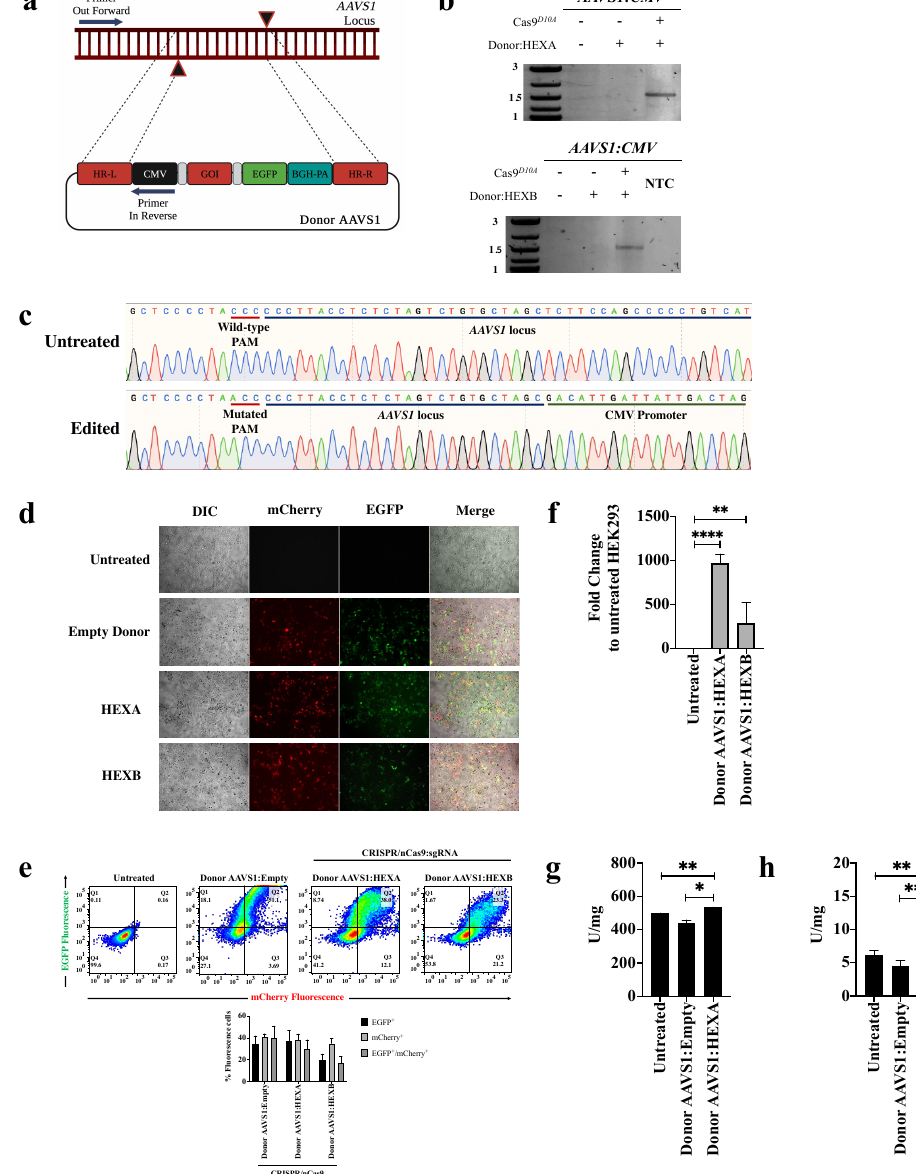
Figure 1. Validation of the CRISPR/nCas9 system on HEK293 cells. ( a ) Molecular strategy for homologous recombination assays. A set of primers flanking a sequence of the AAVS1 locus (which is absent in the homologous recombination left arm) and the CMV promoter were designed to amplify a region of 1.5 kb. Only the successful knock-in of the Donor AAVS1 allows for amplifying the expected fragment. GOI refers to HEXA or HEXB cDNA. ( b ) PCR products from cells transfected with CRISPR/nCas9 and Donor AAV1:HEXA or Donor AAV1:HEXB plasmids. ( c ) Electropherograms from Sanger sequencing performed on PCR products. In the reverse sequence, note the mutated PAM sequences inserted in the Donor plasmid [24]. ( d ) Epifluorescence assays to visualize the EGFP and mCherry signals. ( e ) Transfection ratio quantitation by flow cytometry ( n = 5). Transcription assays (( f ), n = 3) and specific Hex A (( g ), n = 4) or Hex B (( h ), n = 4) enzyme activities are also shown. * p ≤ 0.05, ** p ≤ 0.01, **** p ≤ 0.0001. Two-tailed Student’s t